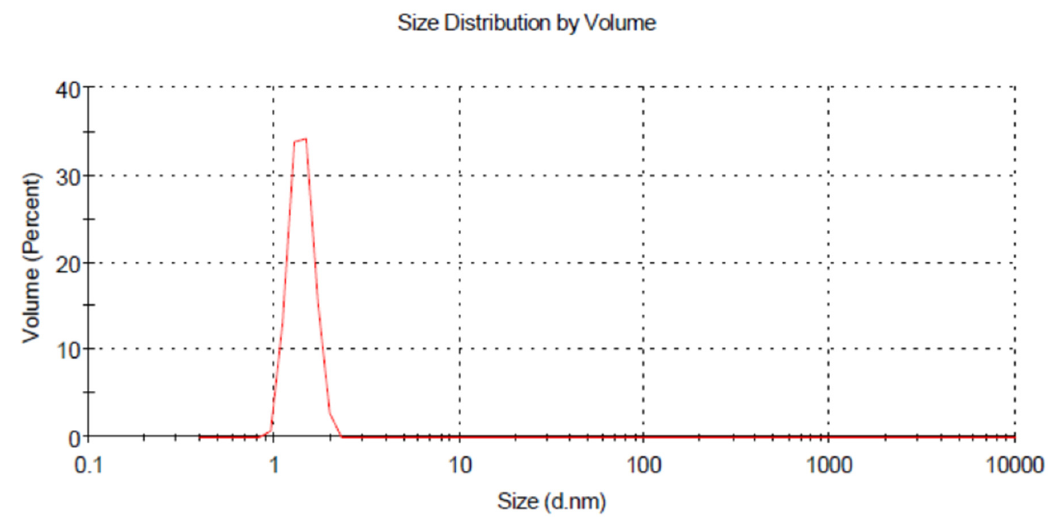
Figure 4. Z average size of SA NPs, 26.6 nm.